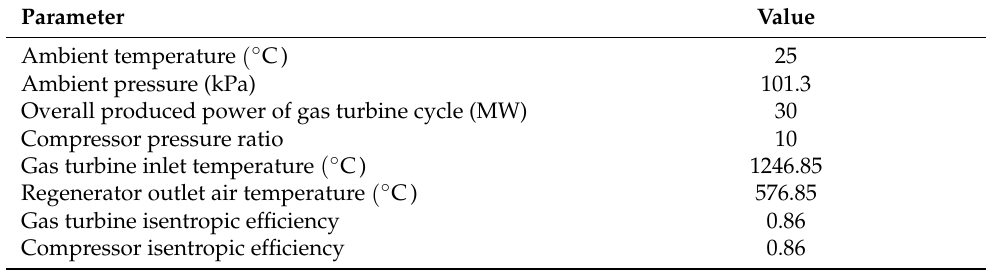
Table 5. Input values for Brayton cycle of the system according to data reported in [28].